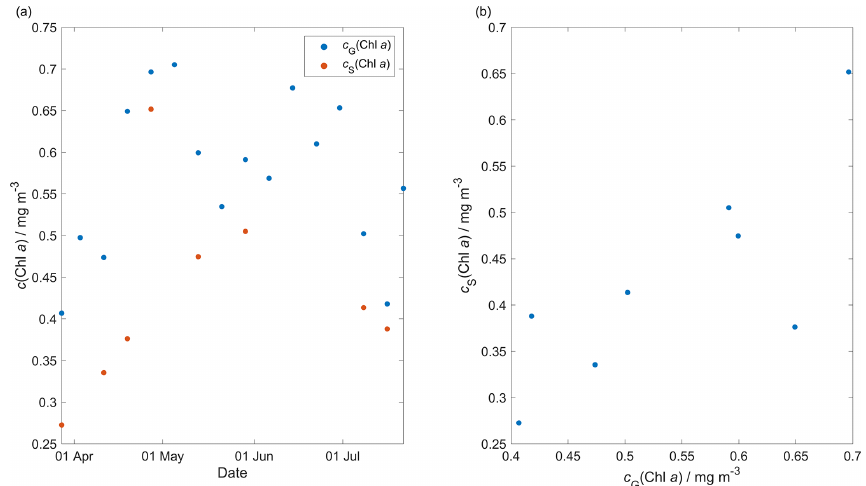
Figure 7. Comparison between the 8d glider c (Chl a ) ( c G (Chl a )) mean and the 8d satellite c (Chl a ) ( c S (Chl a )) download from Ocean Colour CCI (https://esa-oceancolour-cci.org/, last access: 7 May 2020) as a time series (a) and scatter plot (b) .